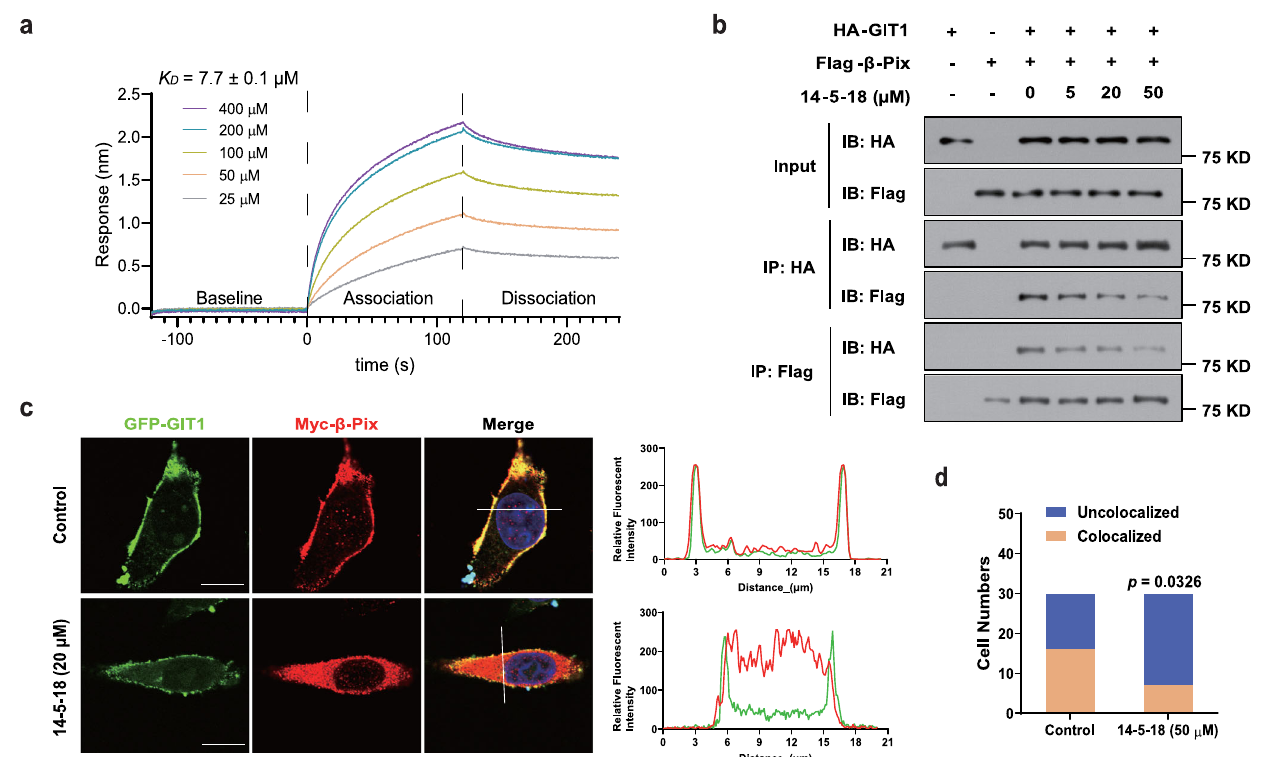
Fig. 3 | Compound 14-5-18 interrupted the GIT1/ β -Pix interaction. a Kinetic measurementofthebindingaf fi nityof 14-5-18 toGIT1byBLIassay.Concentrations rangingfrom25to400 μ Mwereshownwiththereal-timeresponseforeachstepof thekineticassay. b Co-IPassaytoindicatetheinteractionof GIT1and β -Pixandthe inhibitory effects of 14-5-18 . HA-GIT1 and Flag- β -Pix were transfected into HEK- 293T cells, and the cell lysates were collected to perform the co-IP assay at con- centrations of 0, 5, 20, and 50 μ M. The demonstrated blots were representatives from three independent experiments with similar results. c Fluorescence coloca- lization experiment to visualize the cell distribution of GIT1 and β -Pix with or without treatment of 14-5-18 . GFP-GIT1 (green) and Myc- β -Pix were expressed